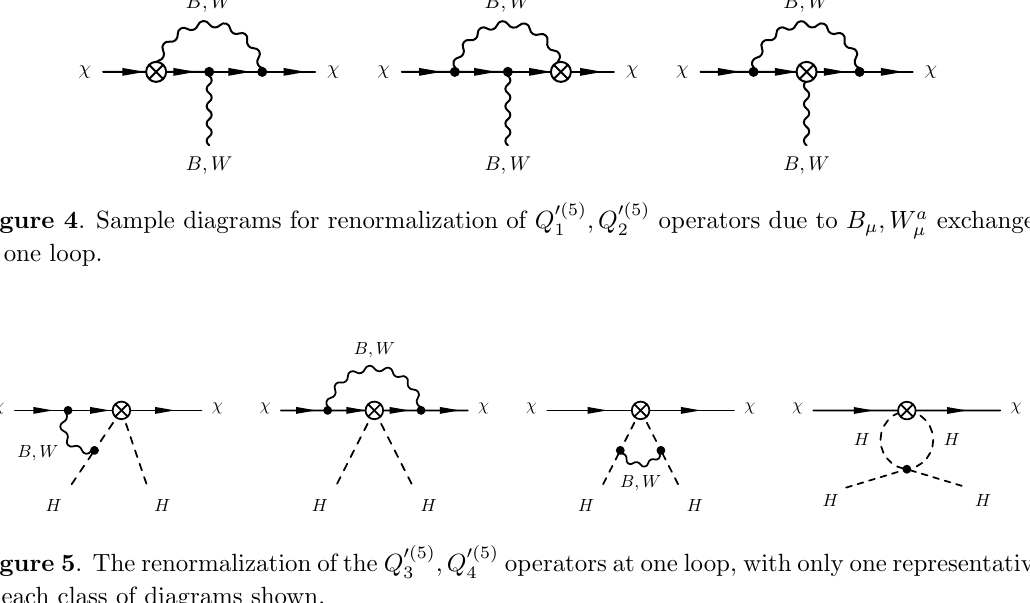
exchanges (cid:22)